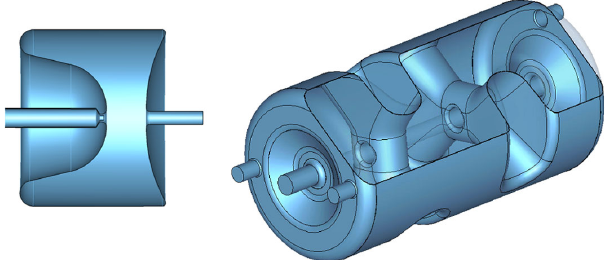
FIG. 9. A cross section picture of the SRF gun (left) and the SRF double-spoke accelerating cavity (right).